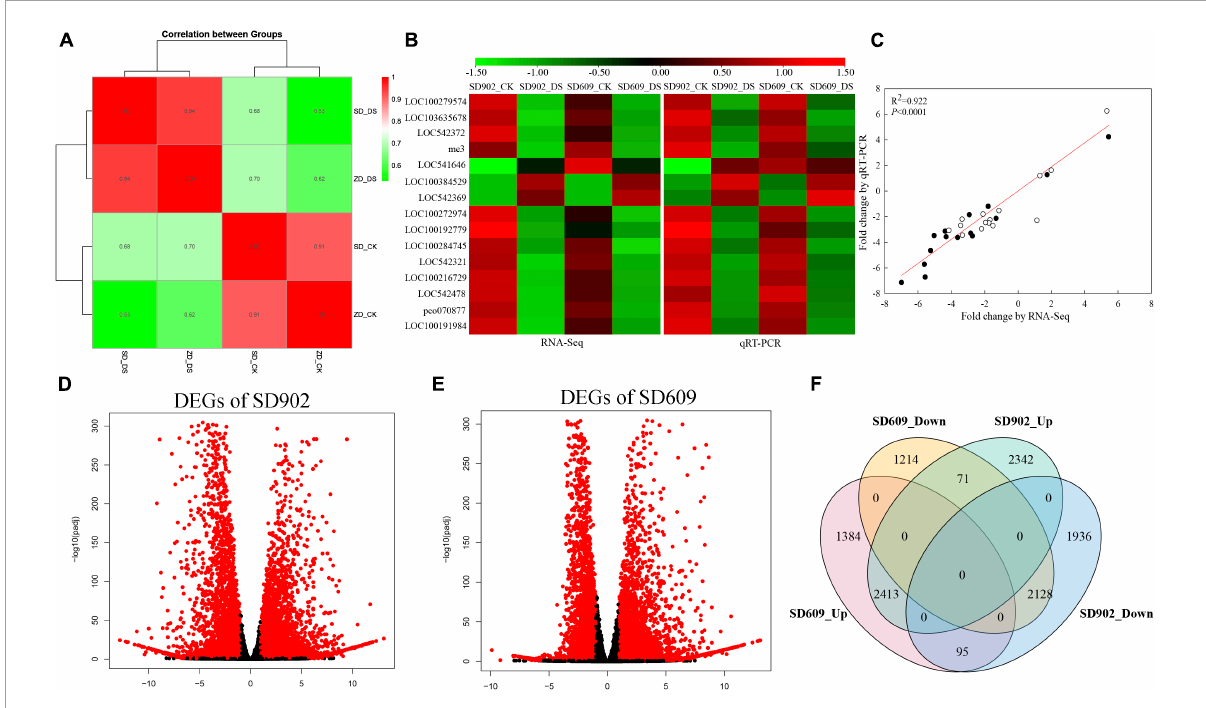
FIGURE2 Genome-wide screen and expression analysis of differentially expressed genes (DEGs) between SD902 and SD609 based on RNA-seq. (A) Pearson correlation analysis of three biological replicates. (B) Validation of the RNA-seq results by qRT-PCR method. (C) Correlation analysis of gene expression value obtained from the RNA-seq and qRT-PCR. White and black circles, respectively, represent correlation of RNA-seq and qRT-PCR results in SD902 and SD609. (D,E) Upregulation and downregulation of DEGs between the two genotypes. Red and black dot symbols, respectively, represent significant difference genes and insignificant difference genes. (F) Venn diagram illustrating the number of upregulated and downregulated DEGs between SD902 and